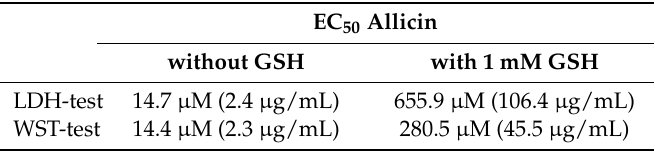
Table 3. Sensitivity of rat lung tissue slices to allicin. EC 50 values for allicin in the lactate dehydrogenase (LDH) and water soluble tetrazolium (WST) tests either in the absence or presence of 1 mM